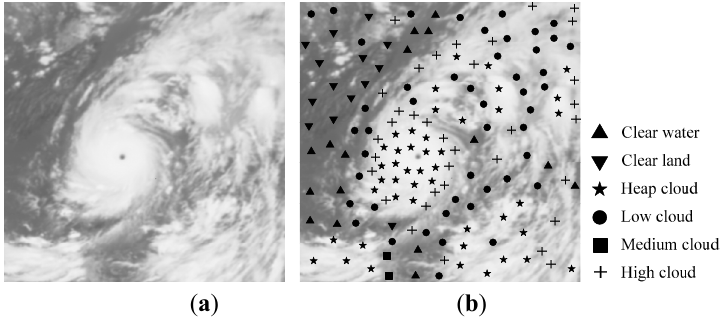
Figure 6. Original IR1 image and cloud types labeled image. ( a ) IR1 image; ( b ) Same image as (a) with cloud types labeled by a meteorologist.